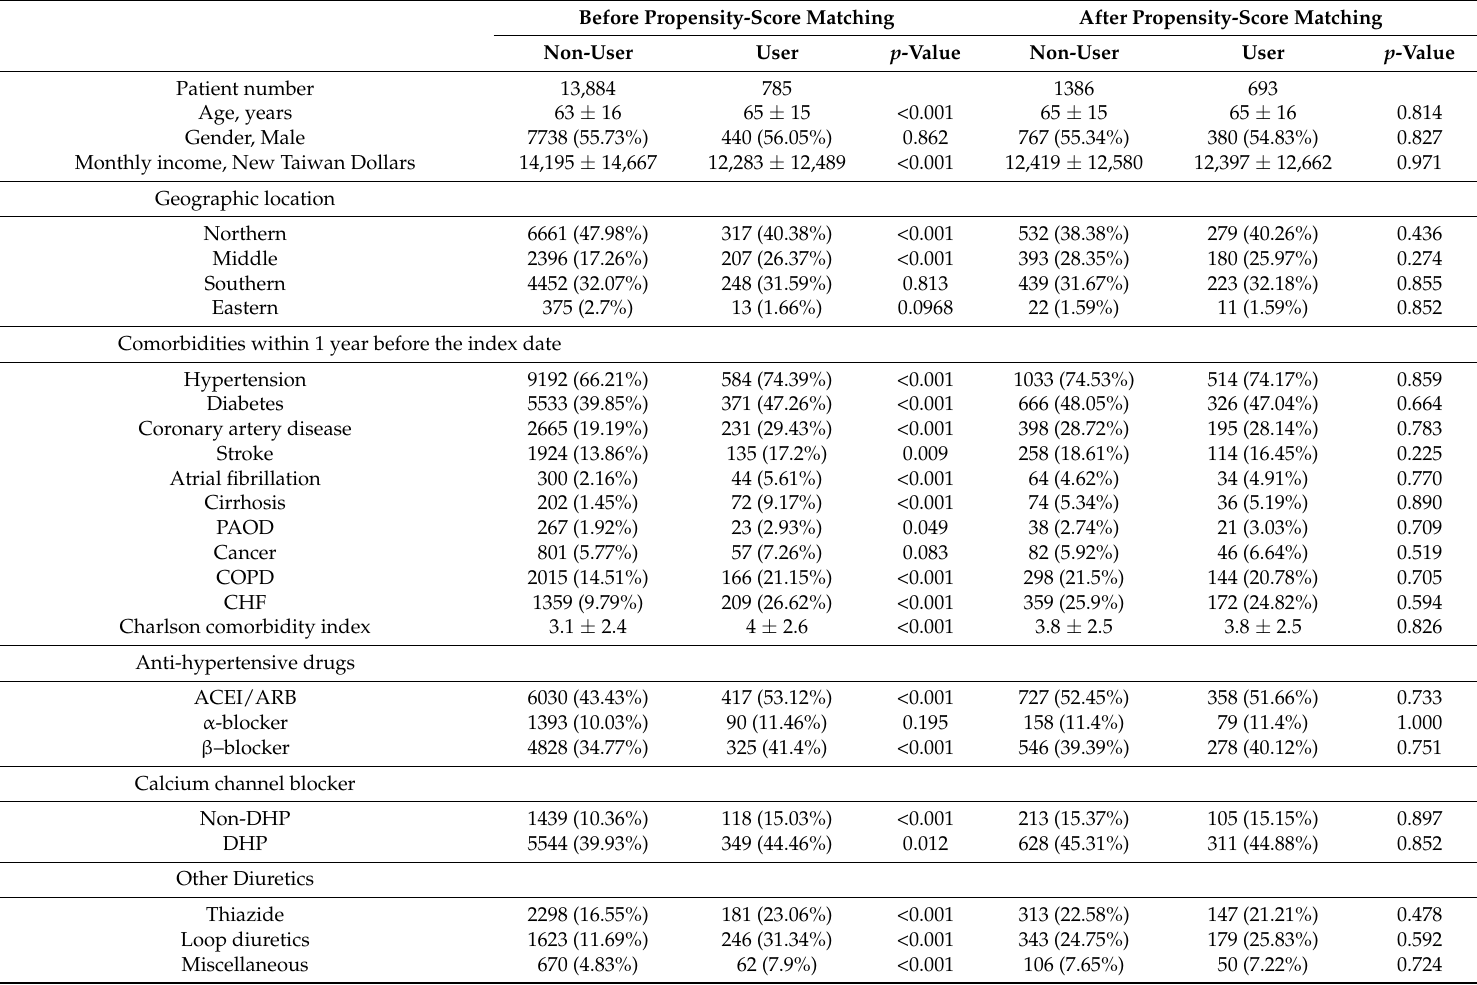
Table 1. Baseline characteristics and clinical outcomes of study patients by spironolactone use before and after propensity score